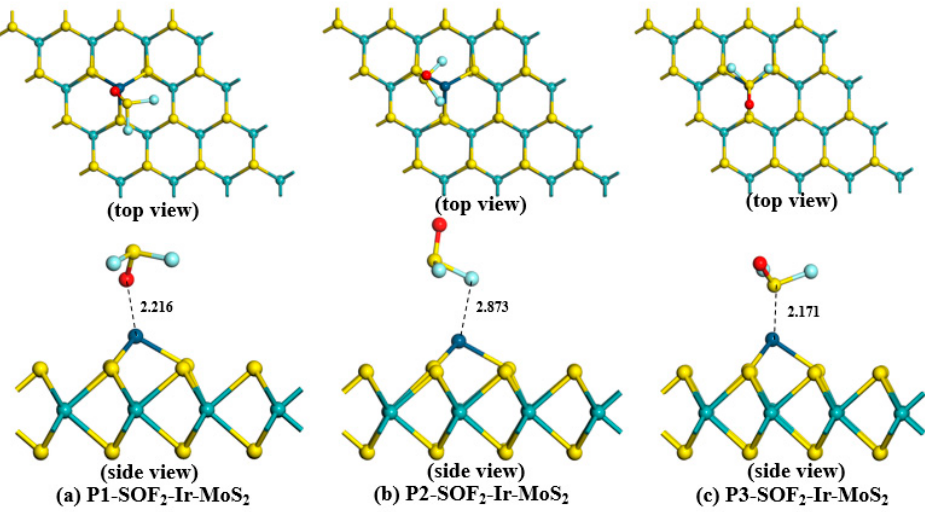
Figure 5. Different optimized structures of SO 2 adsorption on the Ir-modified MoS 2 surface. Nanomaterials 2020 , 10 , x FOR PEER REVIEW 6 of 12